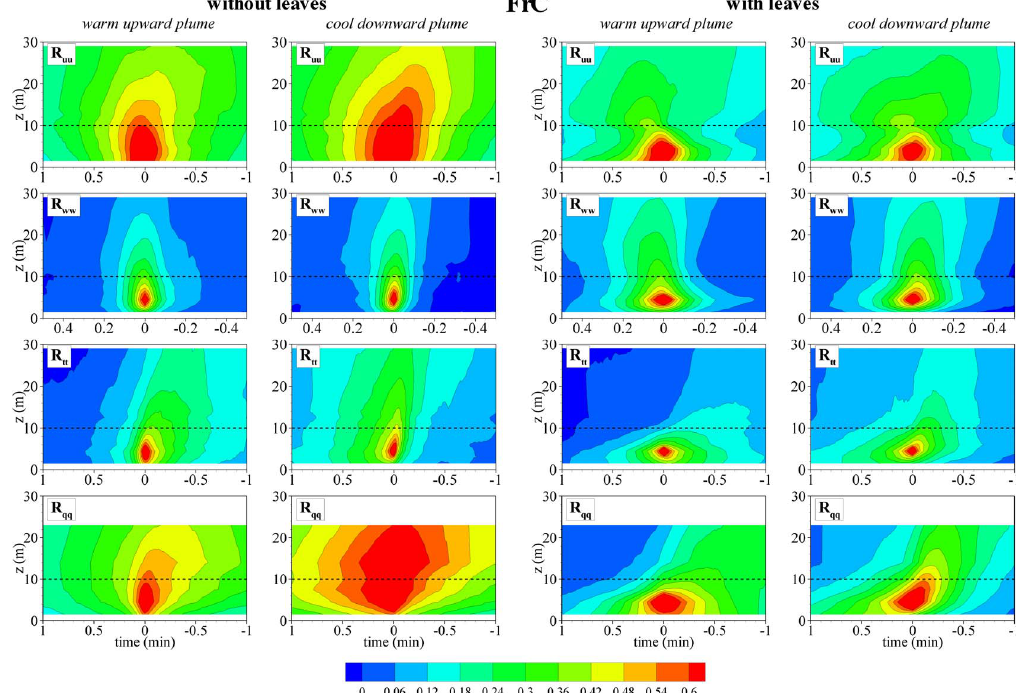
Fig. 8. Same as Fig. 6 but for autocorrelations referenced to Z = 4 .